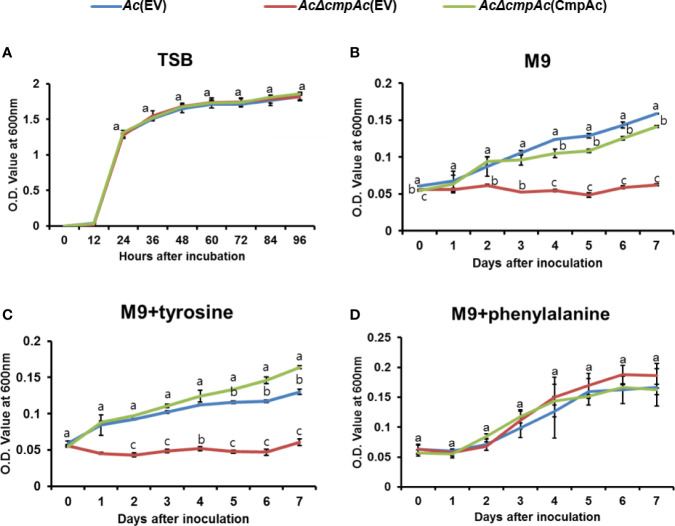
Auxotroph assay. (A) Bacterial growth measurement in (A) tryptic soy broth (TSB). (B) M9 medium without any amino acids. (C) M9 medium with 1 mM tyrosine. (D) M9 medium with 1 mM phenylalanine. The O.D. value at 600 nm (A) for 96 h with 12-h intervals and (B–D) for 7 days with 24-h intervals. Error bars indicate standard deviations. The different letters indicate statistically significant differences by ANOVA with Tukey HSDab (P < 0.05).